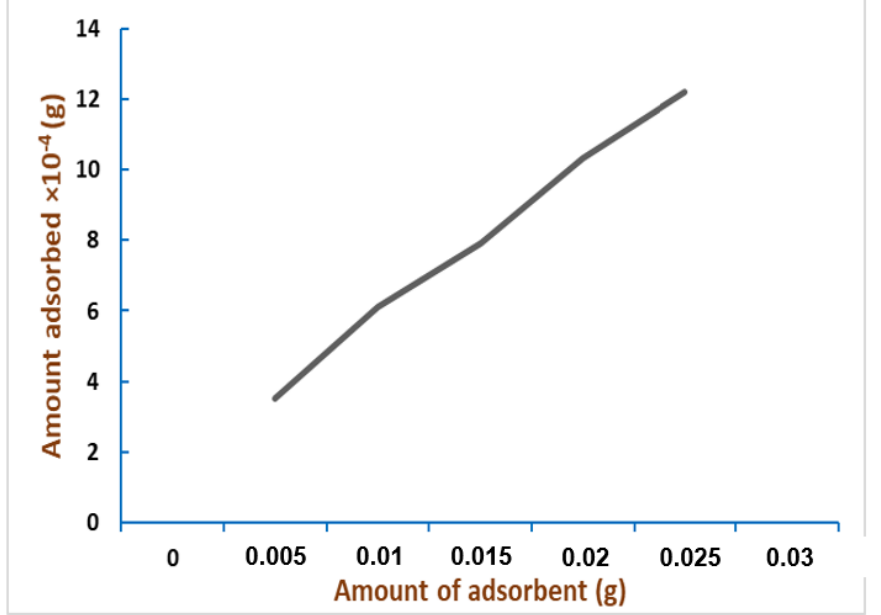
Figure 7. Correlation between amount of adsorbent and amount of the adsorbate (%) at 50 ◦ C; concentration of the dye = 0.09 mM, pH = 2.0, time = 24 h. Adapted from Reference [48]. Copyright 2007, Elsevier.